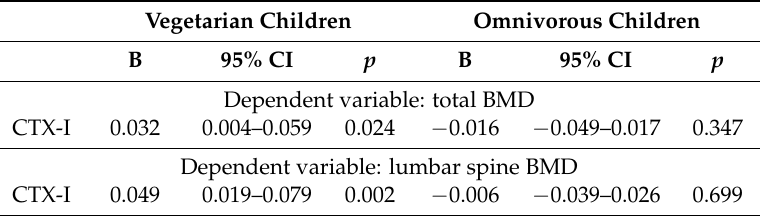
Figure 1. Correlation between serum CTX-I level and tBMD z -score in vegetarians ( r = 0.349, p = 0.003) ( A ); between CTX-I and tBMD z -score in omnivores ( r = 0.026, p = 0.846) ( B ); between CTX-I and BMD L1–L4 z -score in vegetarians ( r = 0.330, p = 0.005) ( C ) and between CTX-I and BMD L1–L4 in omnivores ( r = 0.004, p = 0.977) ( D ). Table 4. The relationship between total body BMD and lumbar spine BMD and serum CTX-I adjusted for age and sex in vegetarian ( n = 70) and omnivorous ( n = 60) children.